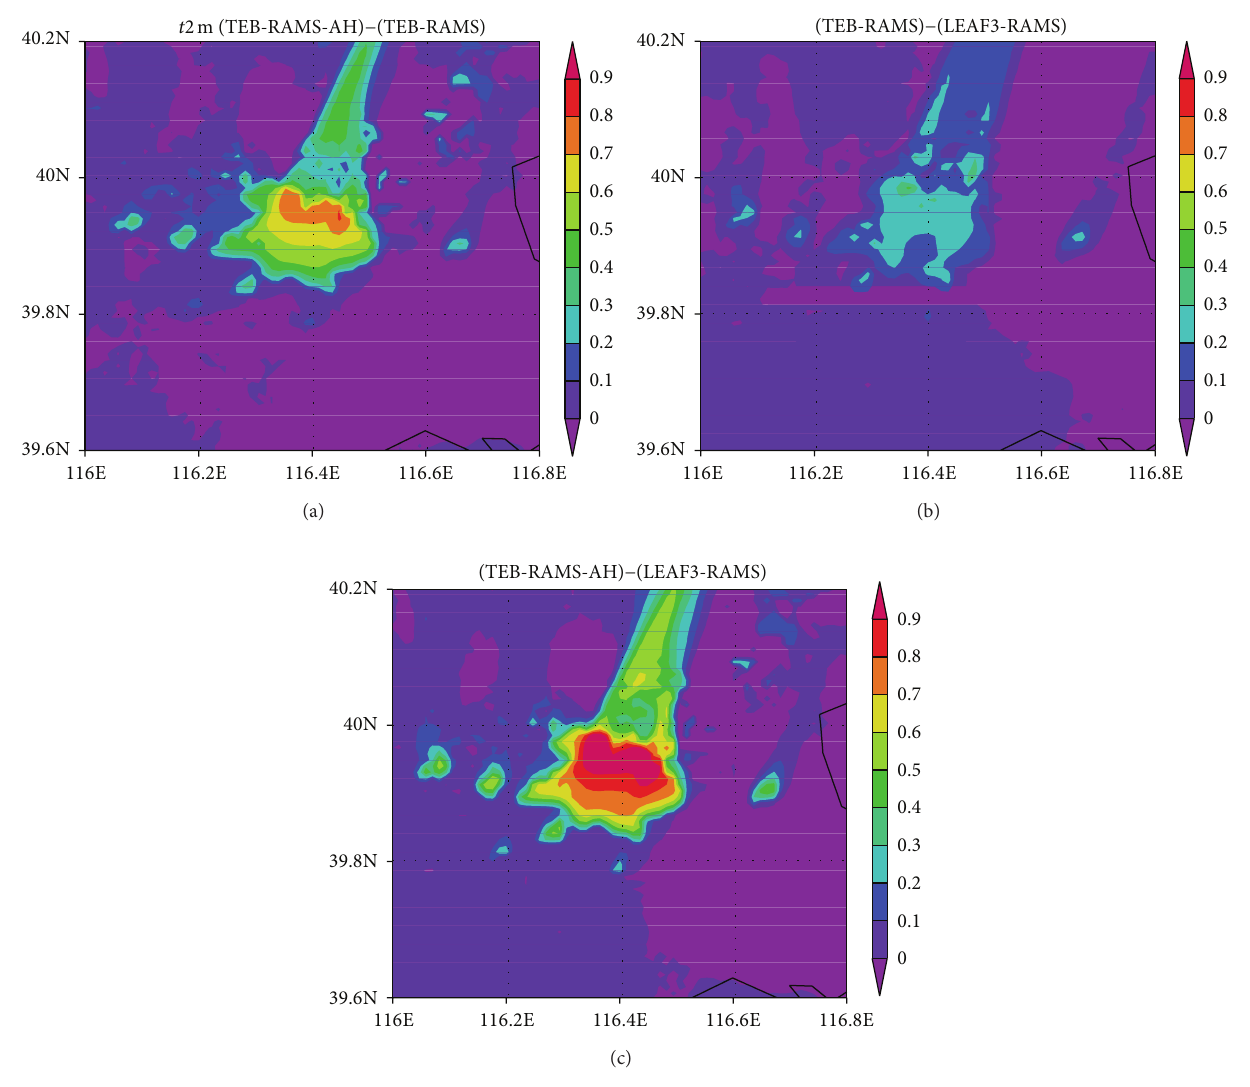
Figure 6: (a) Spatial distribution of the difference of model simulated daily mean 2m air temperature (K) for the period from 0000 UTC (1400 LST) 01 to 0000 UTC 02 July 2003 between the TEB-RAMS-AH and TEB-RAMS models. (b) Same as in (a) but for the TEB-RAMS and LEAF3-RAMS models. (c) Same as in (a) but for the TEB-RAMS-AH and LEAF3-RAMS